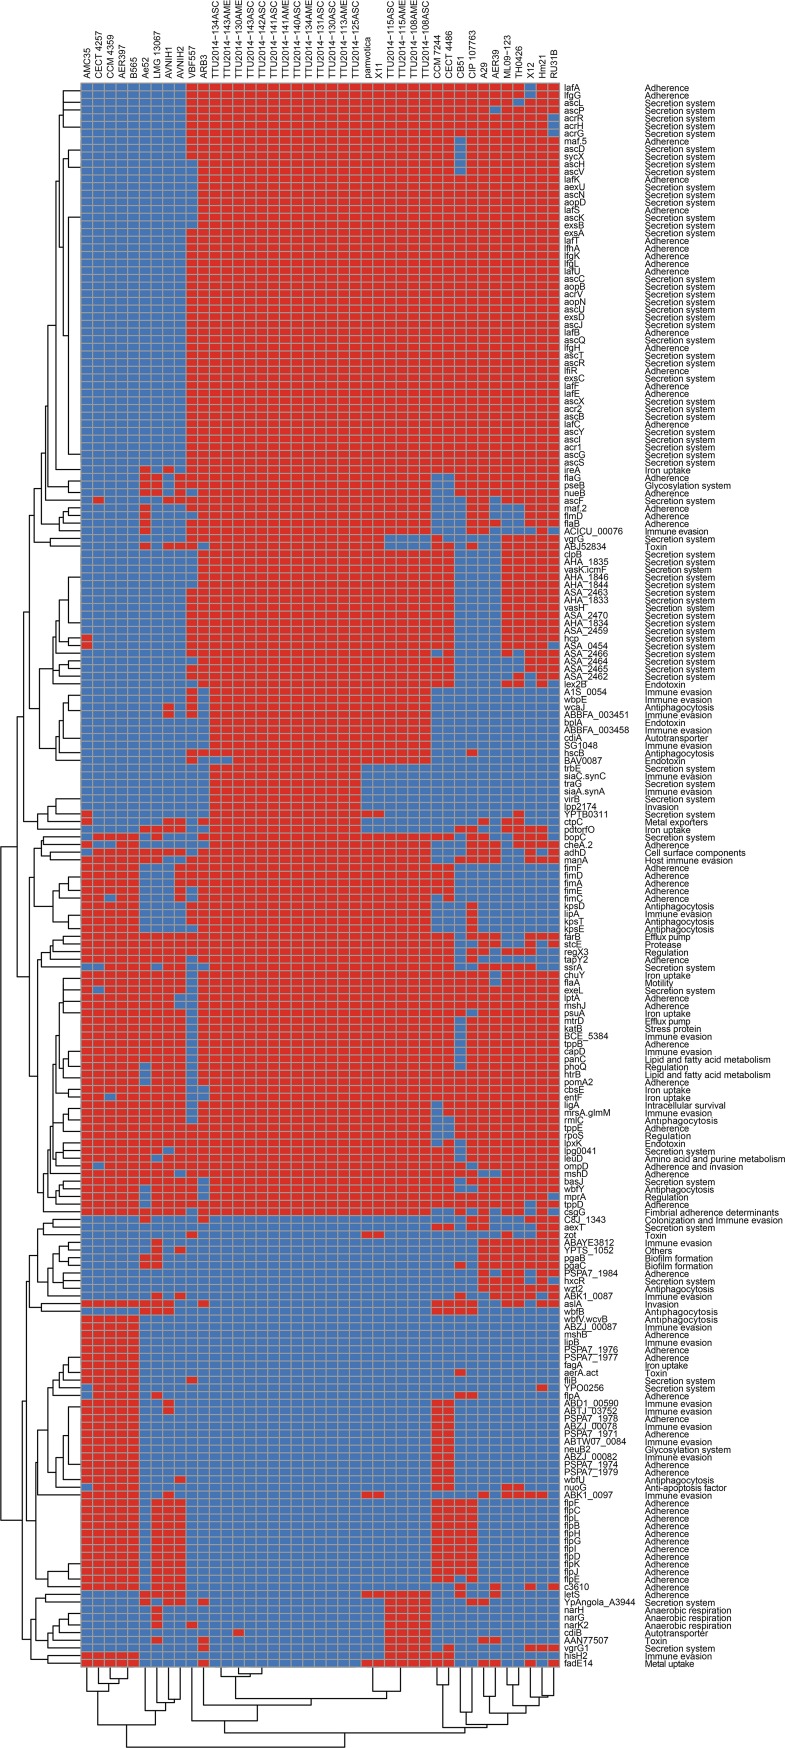
Virulence genes distribution in A. veronii genomes.Red boxes represent presence, blue boxes represent absence.